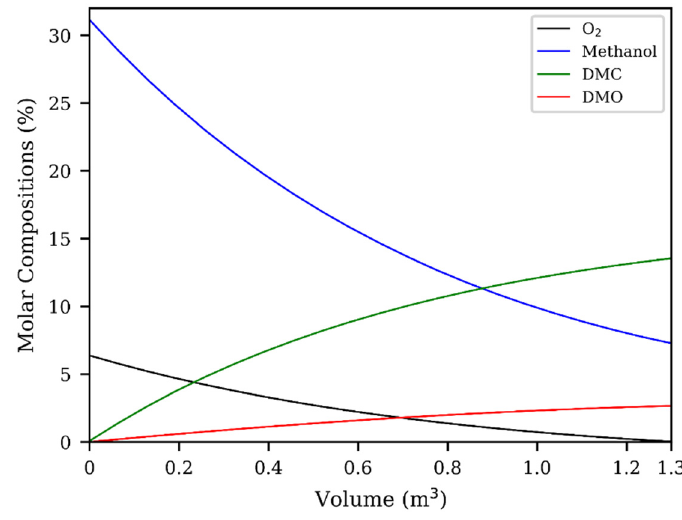
Figure 3. Molar composition of reactants and products along the reactor volume.